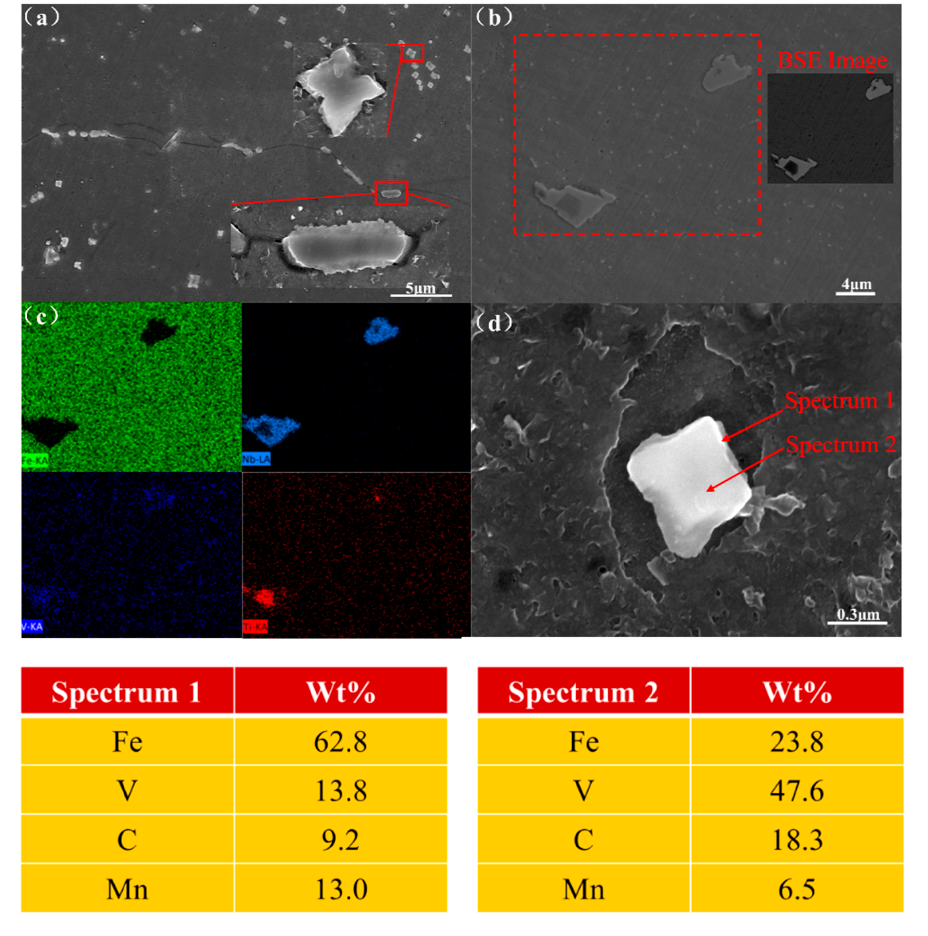
Figure 11. Field emission scanning electron microscope (FESEM) micrographs ( a , b ) and energy spectrum analysis ( c ) of micron-scale precipitates in CHP steel. FESEM micrographs ( d ) and energy spectrum analysis (bottom) of submicron-scale precipitates in CHP steel.